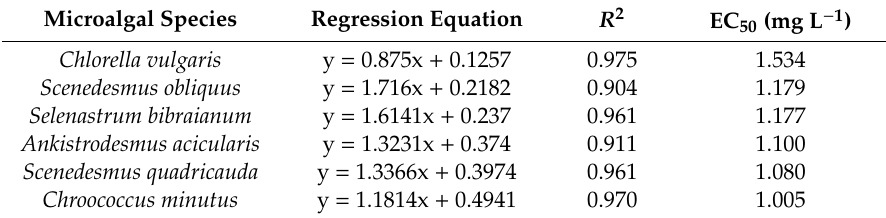
Table 1. Acute toxicity of NP (mg L − 1 ) on six microalgae species at 96 h culture time.